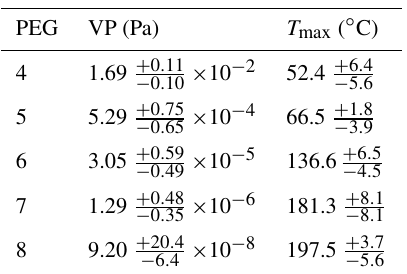
Table 1. Reported vapour pressure measurements of the PEG series (4–8) at 298.15K (Krieger et al., 2018) and associated T max values extracted from the UMan FIGAERO-CIMS. All T max values are an average of four individual thermograms for each PEG sample. Errors in the T max are the maximum variation seen within the four